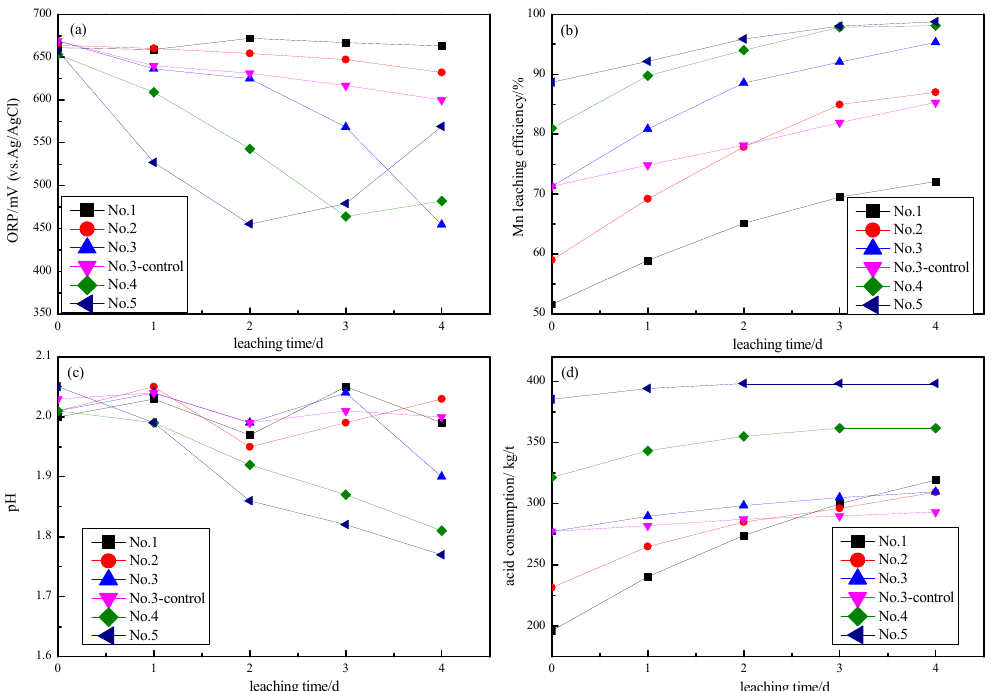
Figure 5. Changes of ORP ( a ), Mn leaching efficiency through the whole two leaching stages ( b ), pH ( c ) and acid consumption ( d ) with leaching time during bioleaching stage.